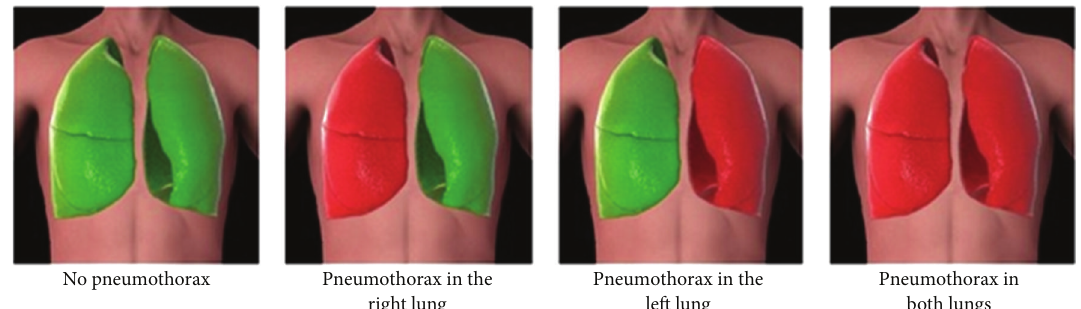
Figure 3: Display of results: red =PTX, green = no